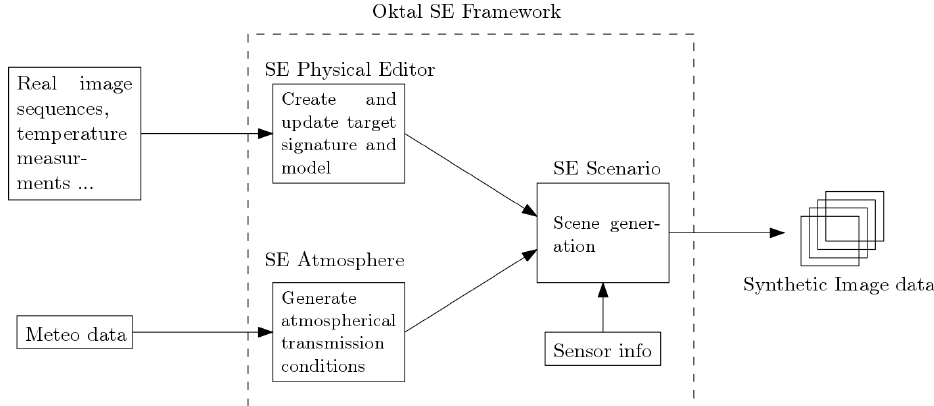
Figure 2. A simplified workflow description of the creation of a synthetic IR scene using